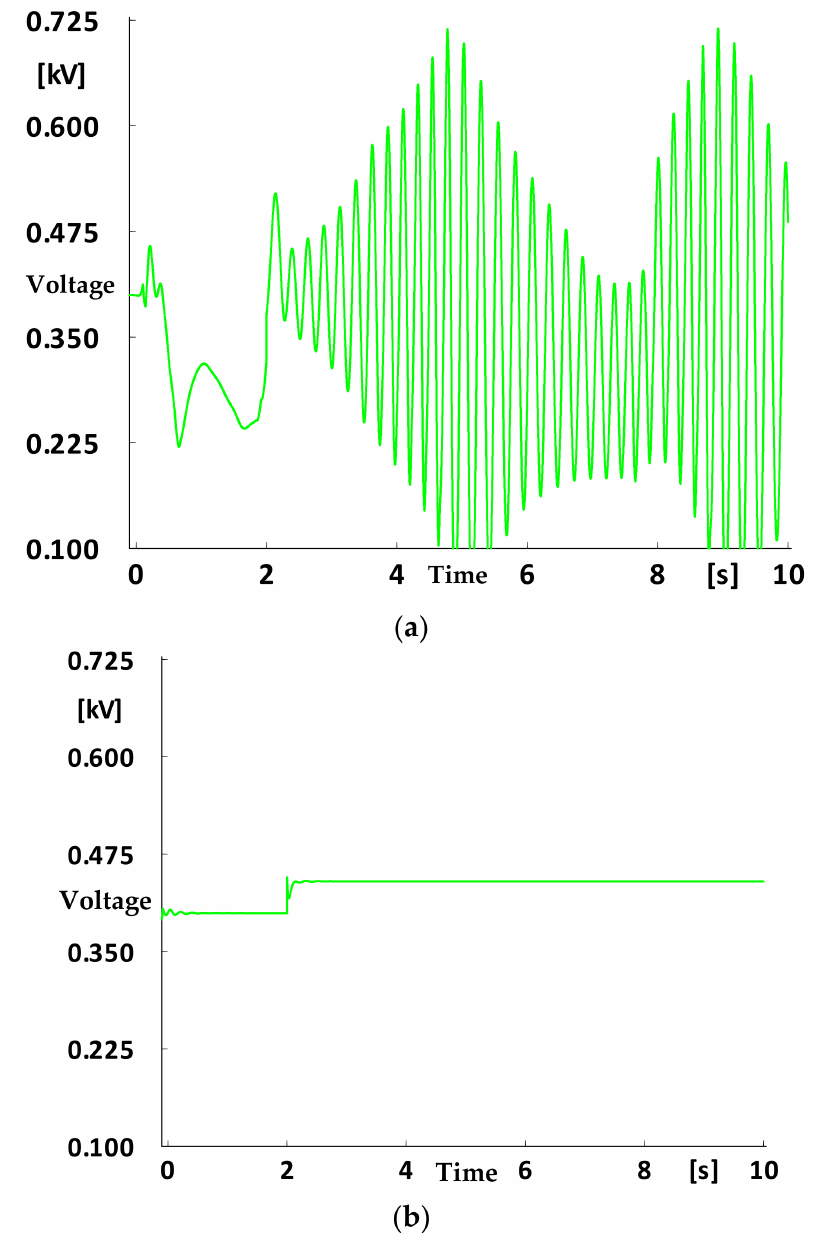
Figure 10. ( a ) Voltage waveform without virtual inertia control after a sudden load shedding distur- bance. ( b ) Voltage waveform with virtual inertia control after a sudden load shedding